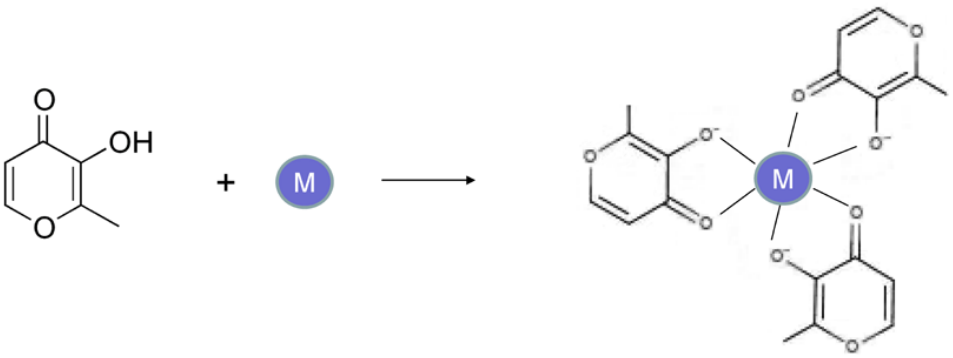
Figure 5. The chemical structure and formation reaction of metal ion complexes of maltol. An octahedral metal ion complex of neutral charge is formed at physiological pH between maltol and trivalent metal (M) ions such as iron, gallium, aluminum and indium. Similar trivalent neutral metal ion complexes are formed using deferiprone (L1).